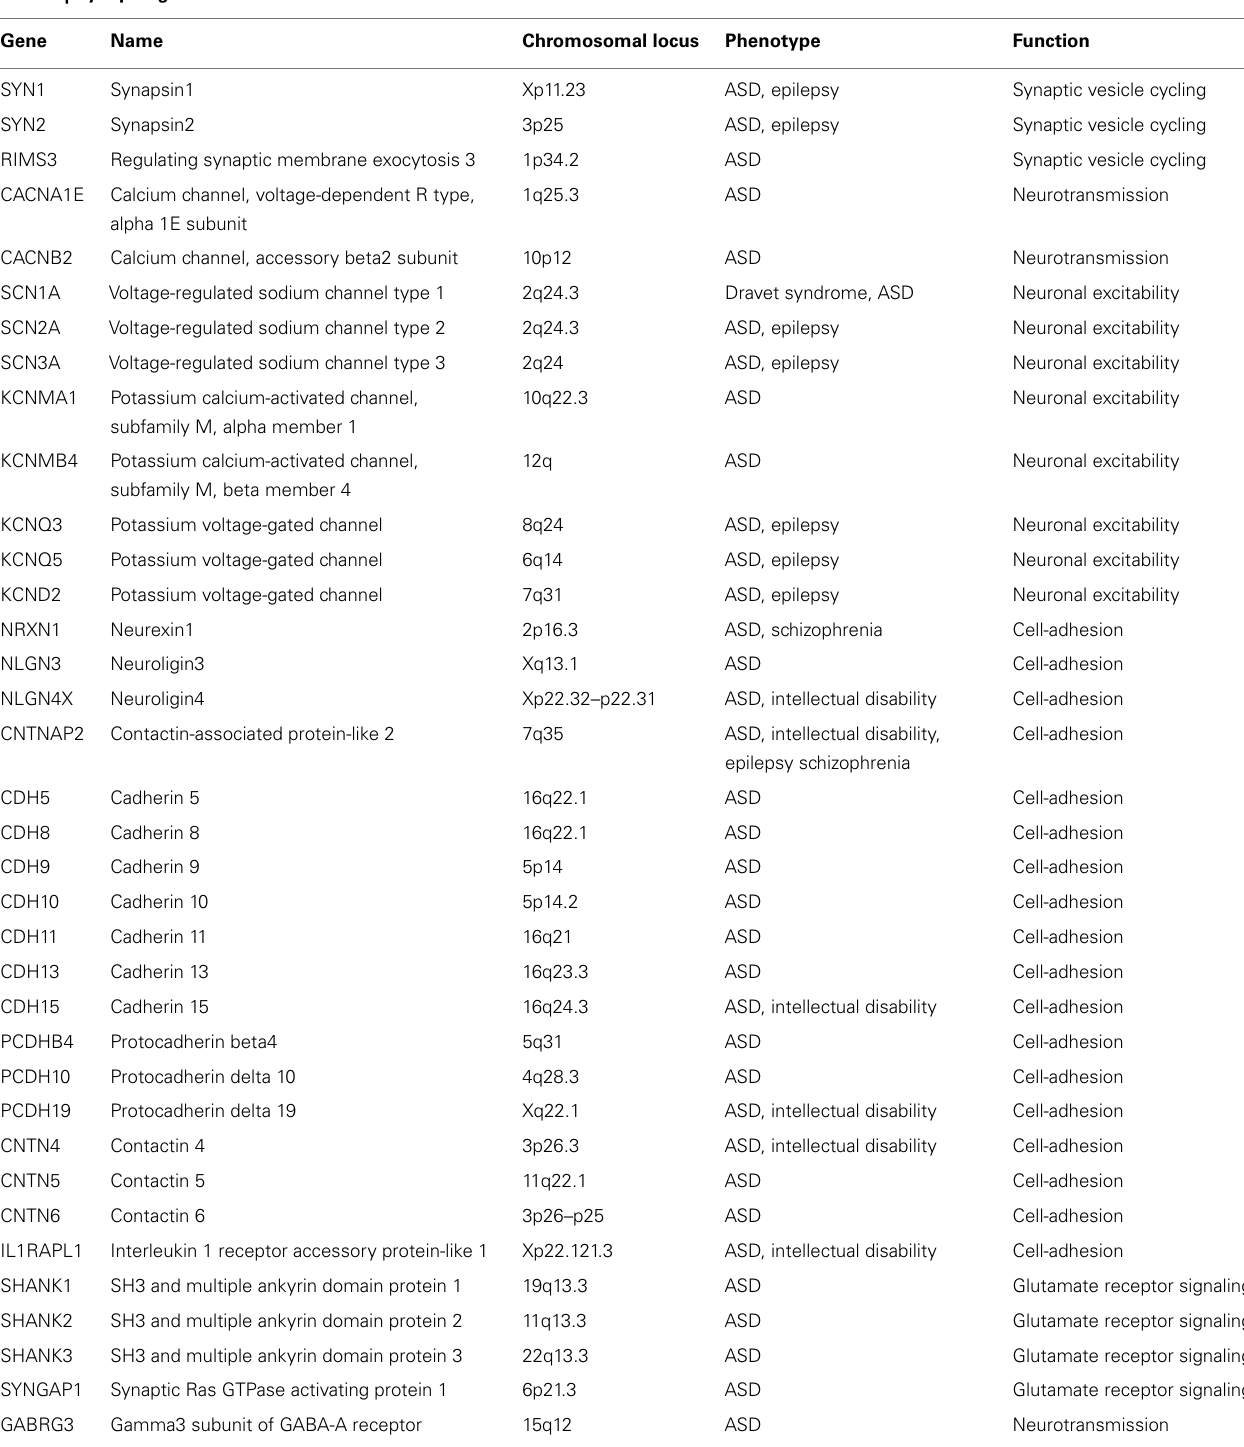
Table 1 | Synaptic genes associated withASD